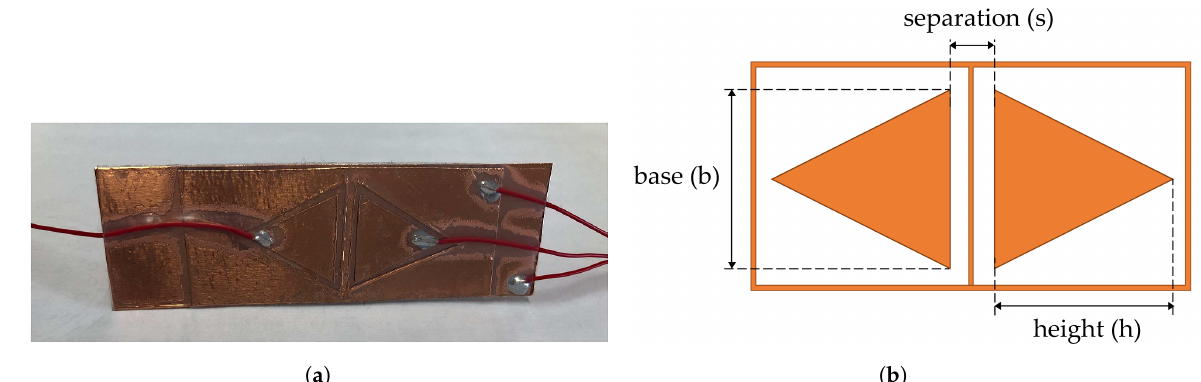
Figure 3. ( a ) Photograph of the pair of triangular electrodes and ( b ) Diagram of the capacitive sensor as viewed from the top